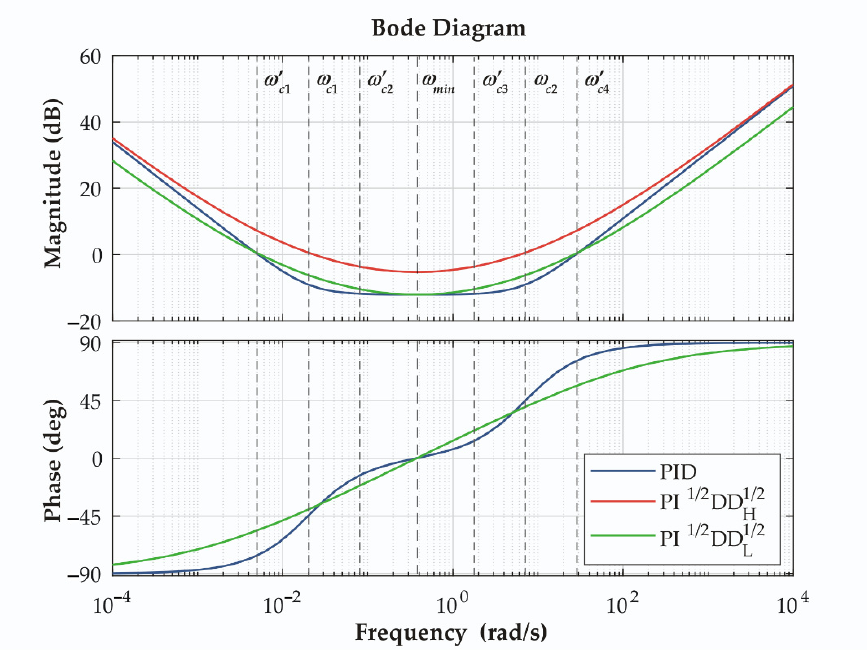
Figure 5. Comparison of the controller Bode plots: PID (blue); PII 1/2 DD 1/2 H (red); PII 1/2 DD 1/2 L (green); the phase plots of the two PII 1/2 DD 1/2 controllers are equal.